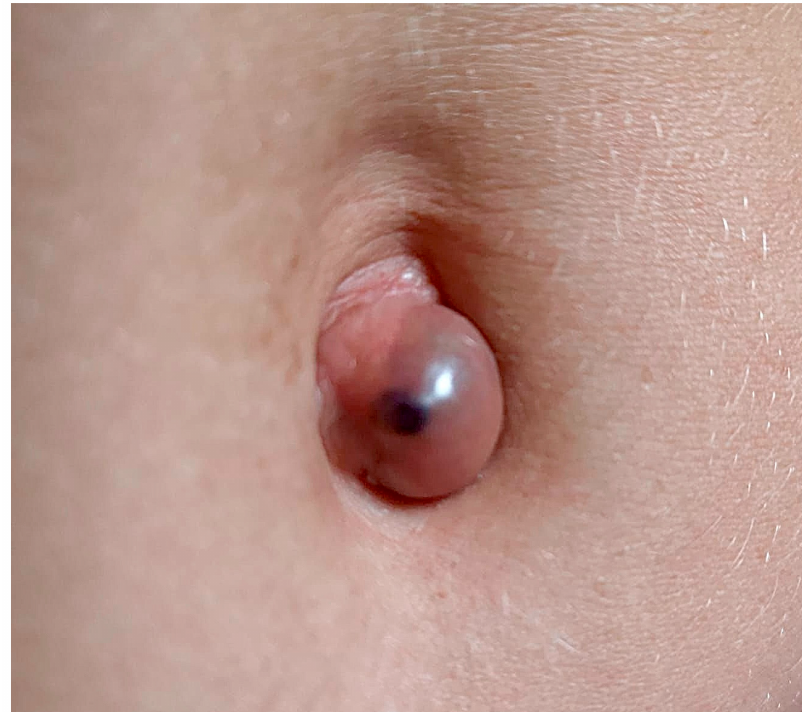
Figure 1. Umbilical endometriosis